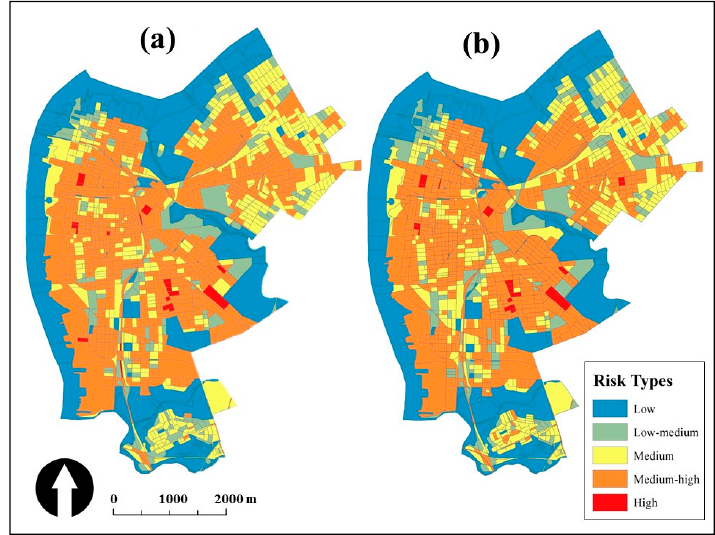
Figure 8. ERII ( a ) and SVII ( b ).